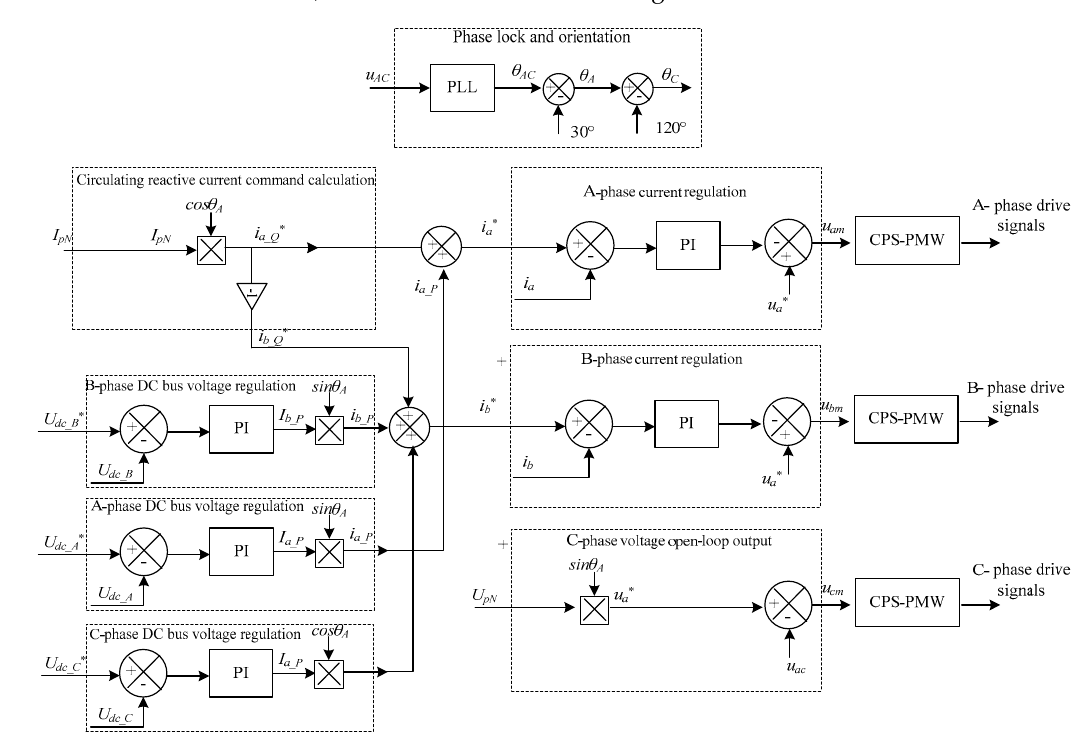
Figure 5. The control system block of the proposed testing system.